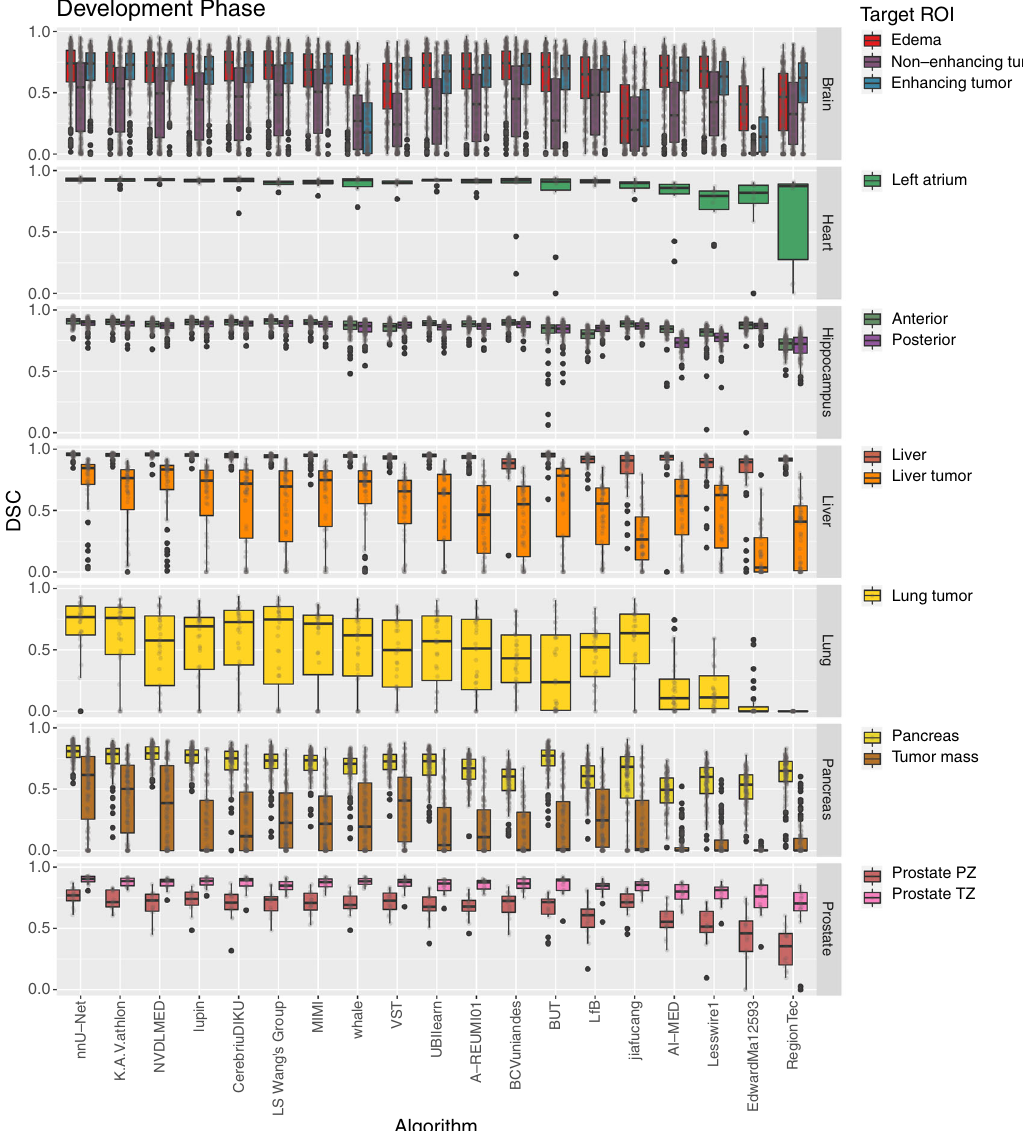
Fig. 3 Dot- and box-plots of the Dice Similarity Coef fi cient (DSC) values of all 19 participating algorithms for the seven tasks (brain, heart, hippocampus, liver, lung, pancreas, prostate) of the development phase, color-coded by the target regions (edema (red), non-enhancing tumor (purple), enhancing tumor (blue), left atrium (green), anterior (olive), posterior (light purple), liver (dark orange), liver tumor (orange), lung tumor (yellow), pancreas (dark yellow), tumor mass (light brown), prostate peripheral zone (PZ) (brown), prostate transition zone (TZ) (pink)). The box- plots represent descriptive statistics over all test cases. The median value is shown by the black horizontal line within the box, the fi rst and third quartiles as the lower and upper border of the box, respectively, and the 1.5 interquartile range by the vertical black lines. Outliers are shown as black circles. The raw DSC values are provided as gray circles. ROI Region of